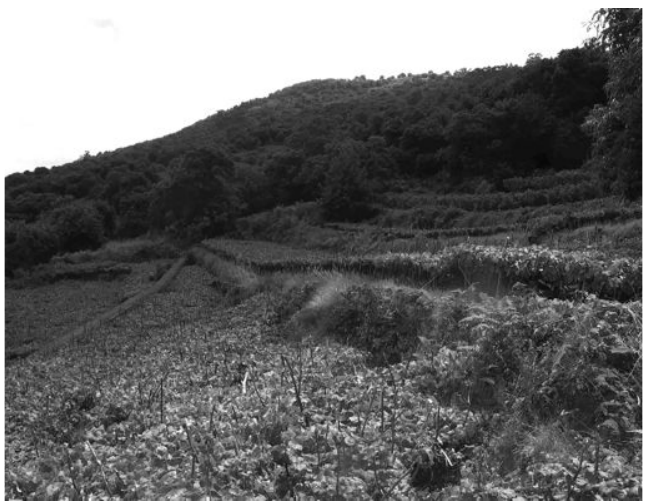
Fig. 4 - Chestnut-grape Association.